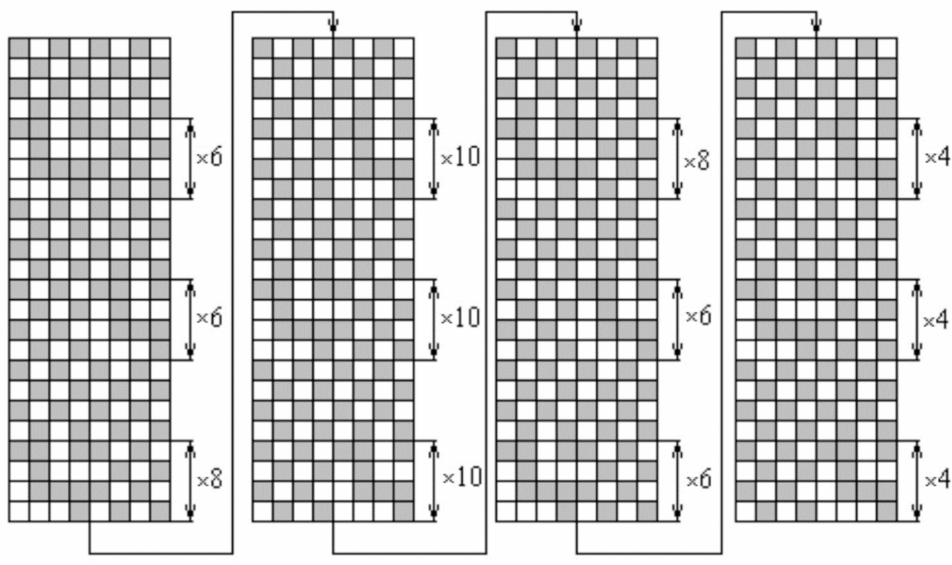
Figure 2. Cards of the woven